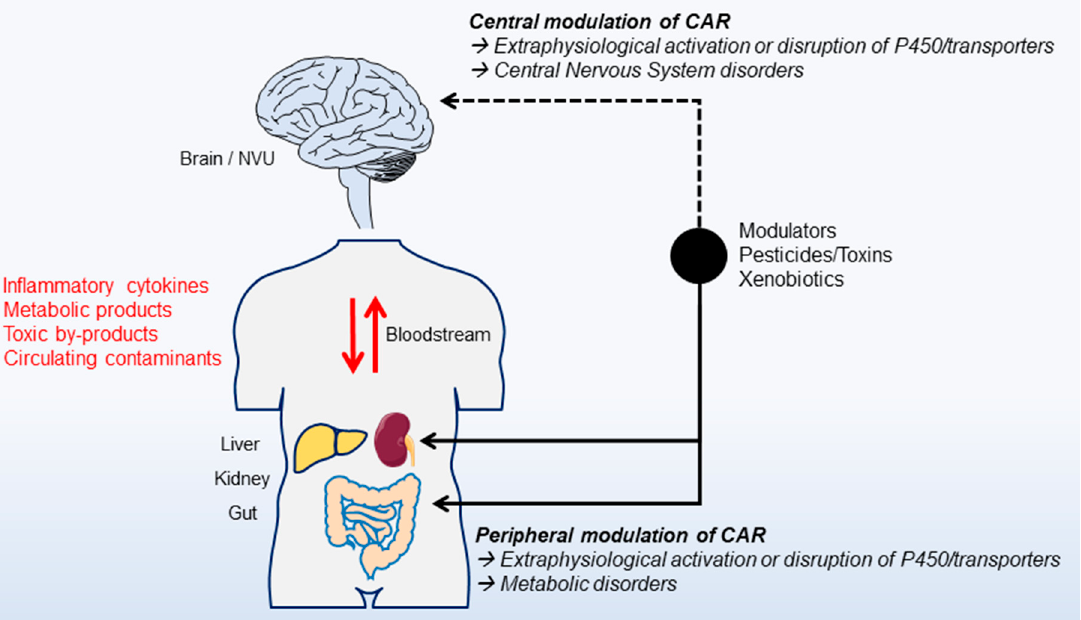
Figure 2. Modulation of CAR activity and a brain-peripheral dialogue. Peripheral or central activities of CAR can be modulated by endogenous or exogenous molecules (e.g., pesticides, toxins, xenobiotics), leading to a disruption of detoxifying p450 cytochromes and transporters regulation. A pathological brain-peripheral dialogue may enable disease conditions via soluble circulating blood factors, such as pro-inflammatory cytokines, metabolic or toxic by-products.